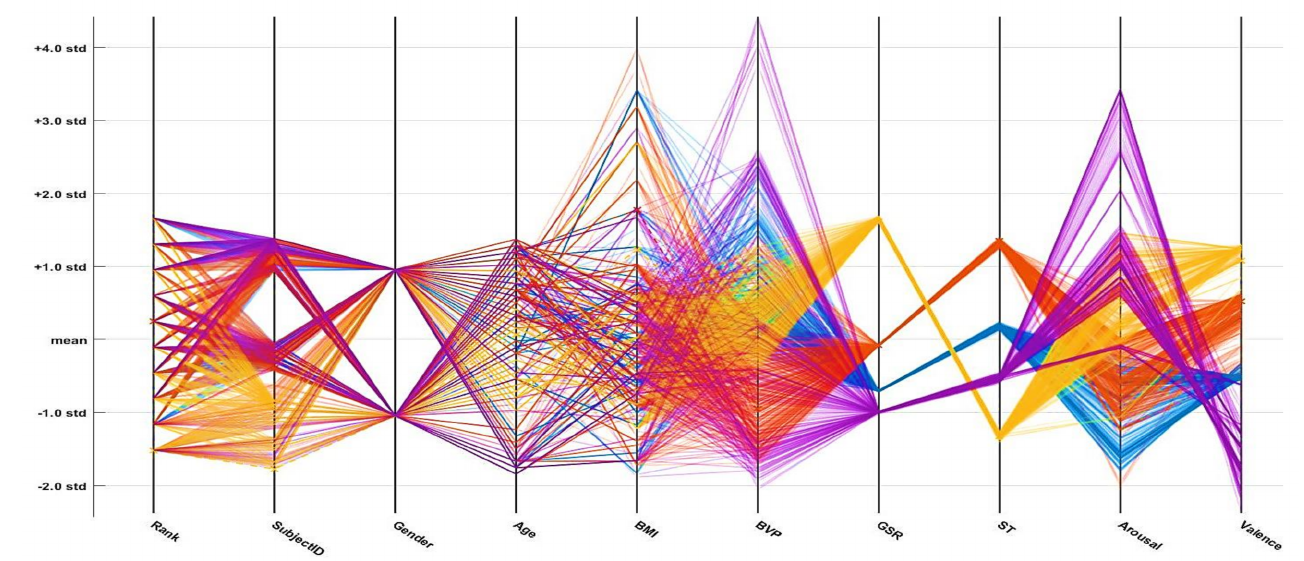
Figure 16. Parallel coordinate plot for the one-dimensional convolutional neural network.